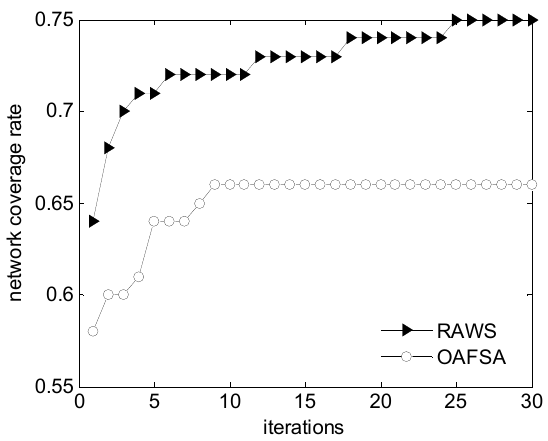
Figure 4. Comparison of network coverage rate at varying iterations.